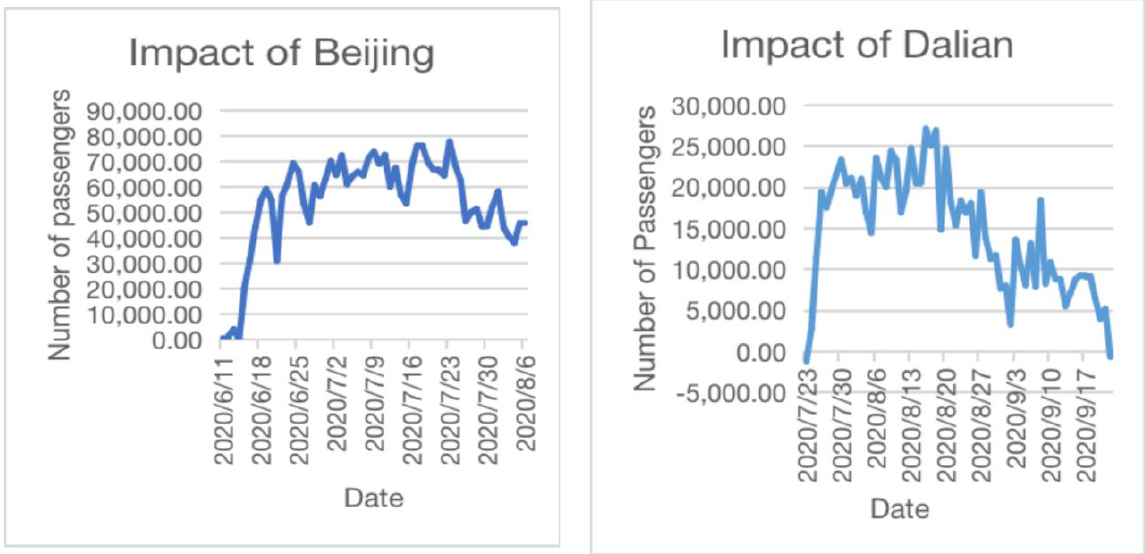
Figure 9. Impact of the local outbreaks in Beijing and Dalian.